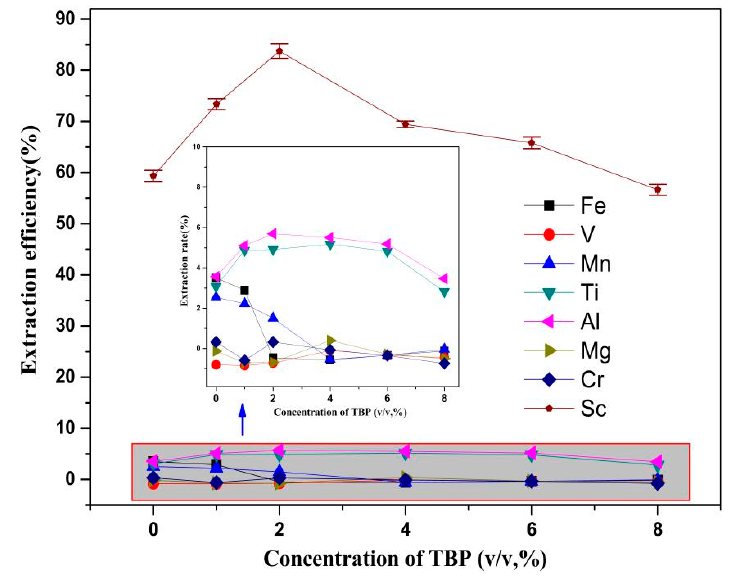
Figure 4. Effect of the modifier TBP concentration on the Sc extraction (8% of extractant D2EHPA, pH = − 0.75, O/A = 1:10, and 5 min at 298 K).